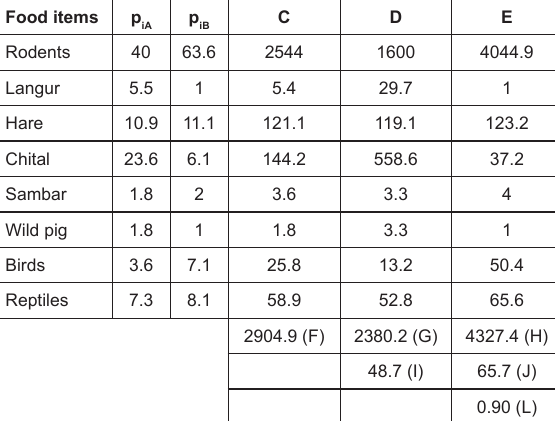
Table 2. Dietary overlap between Golden Jackal and Jungle Cat as shown by scat analysis in Pench Tiger Reserve, Madhya Pradesh.